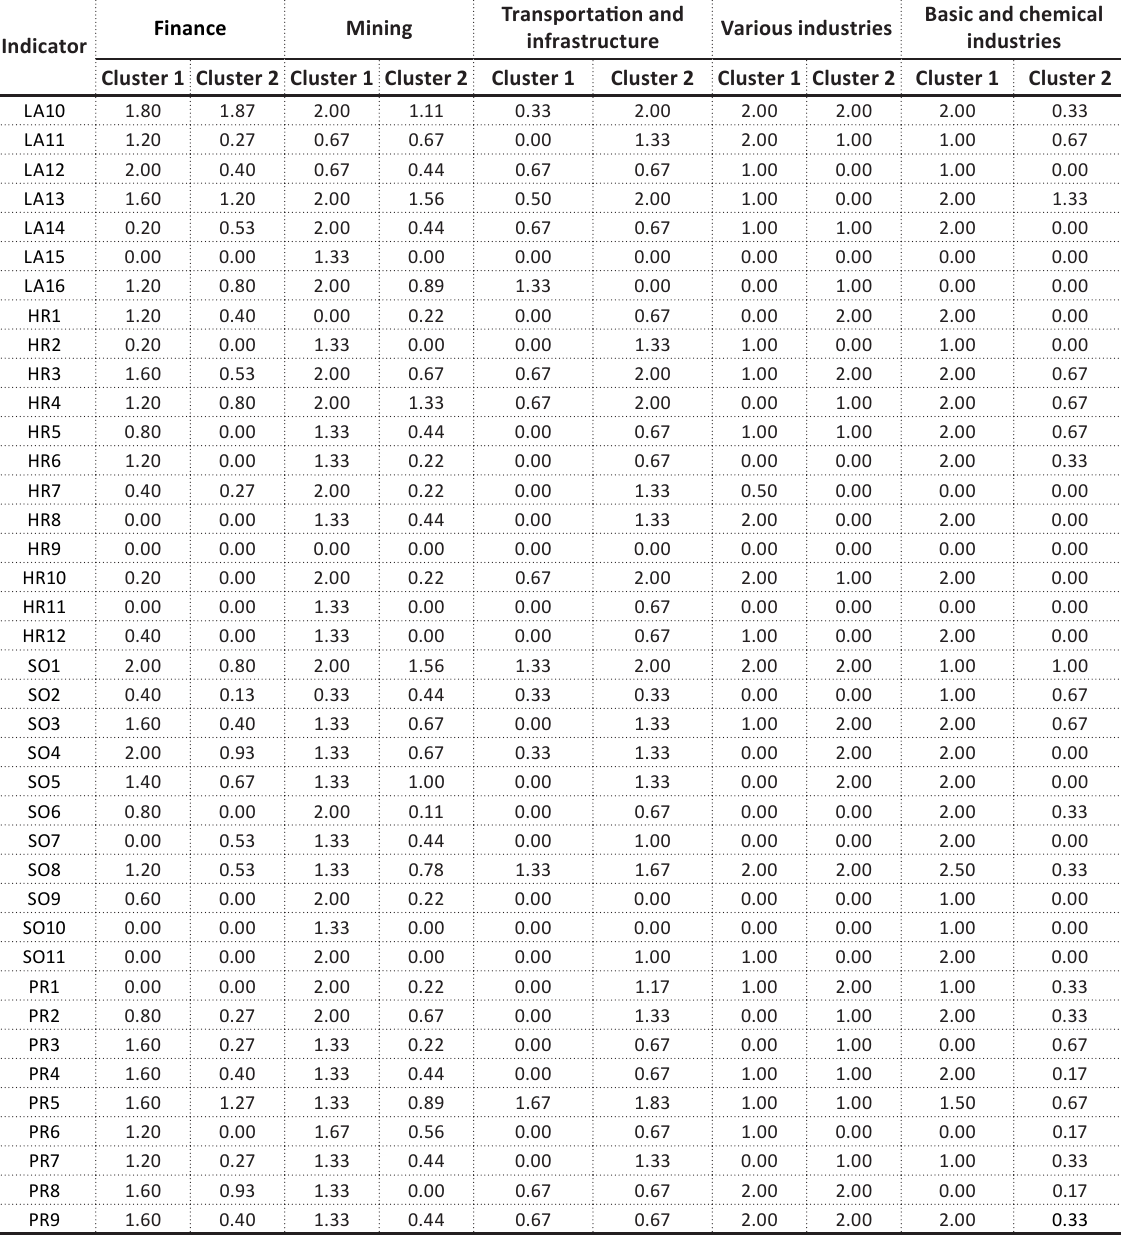
Table 4 (cont.). Final